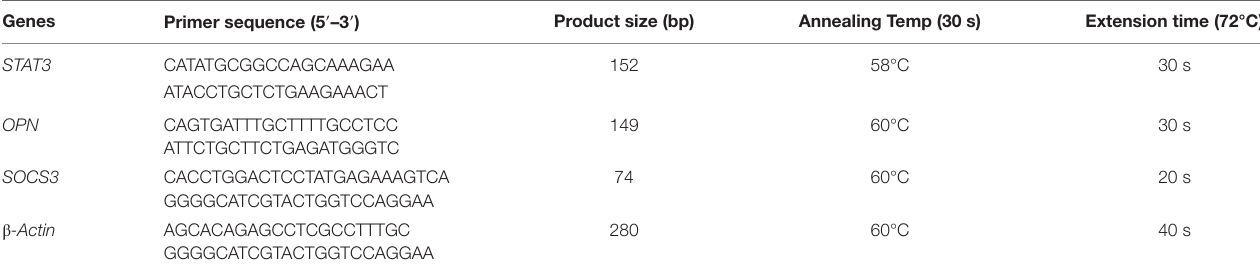
TaBle 3 | Primer sequences and PCR conditions for STAT3, SOCS3, OPN, and β -actin genes.